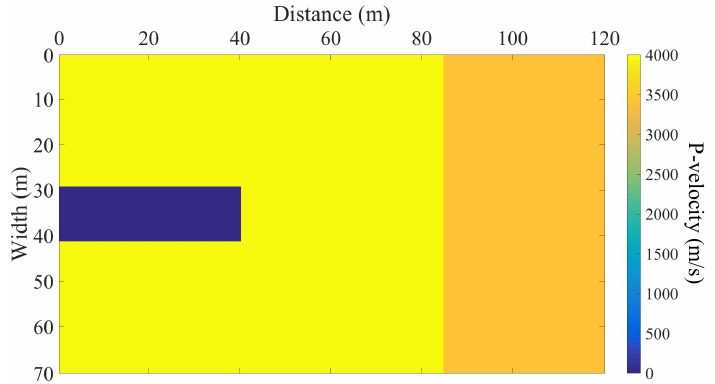
Figure 1. The model with a single vertical geological interface.